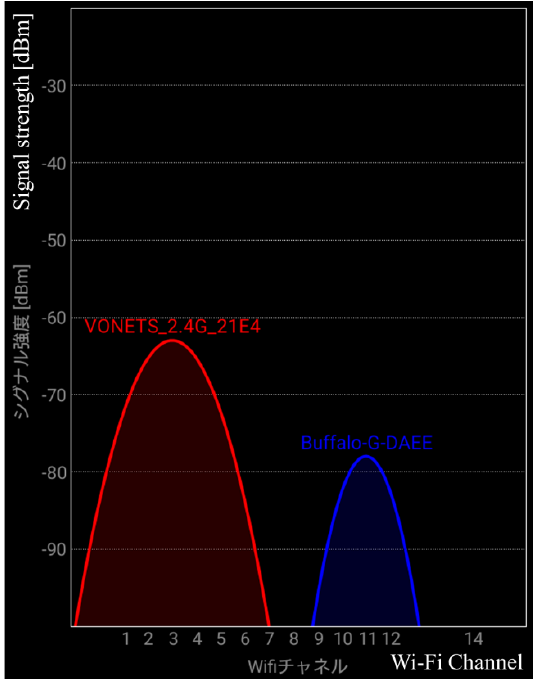
Figure 4. Utilisation of the 2.4-GHz band: Horizontal axis and vertical axis are Wi-Fi channel and signal strength, respectively.